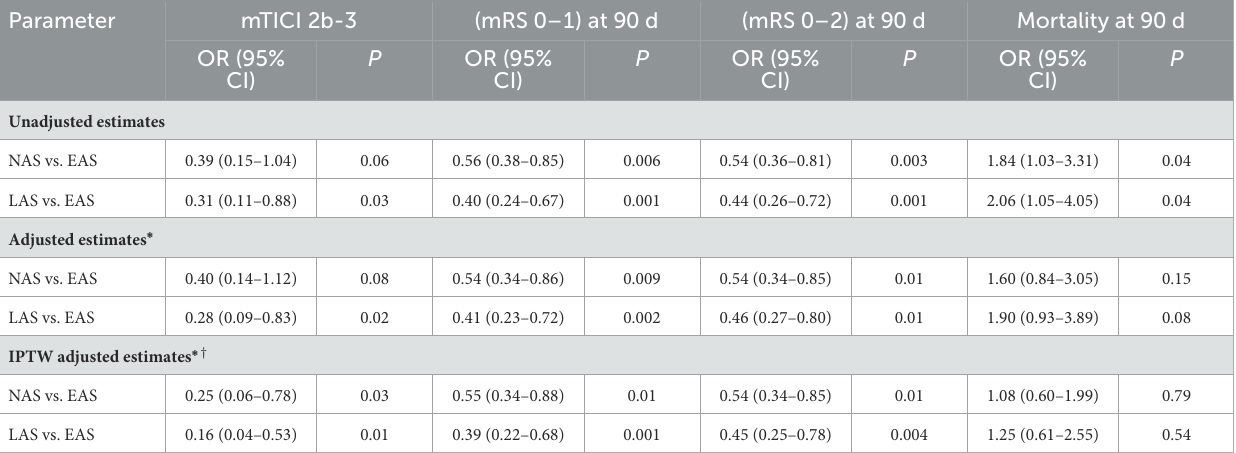
TABLE 2 Comparison of treatment effect of EAS, NAS, and LAS groups.